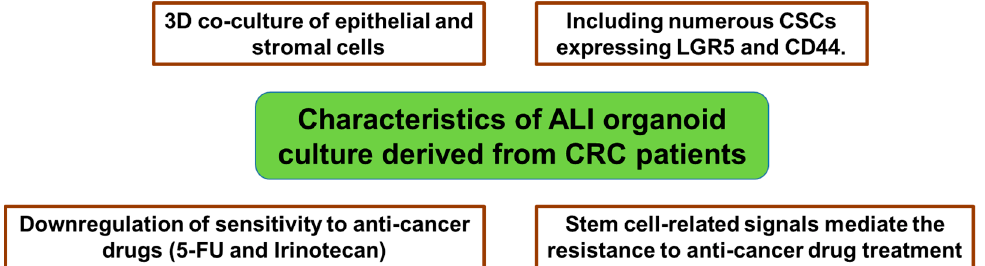
Figure 3. Characteristics of air-liquid interface (ALI) organoid culture derived from CRC patients.